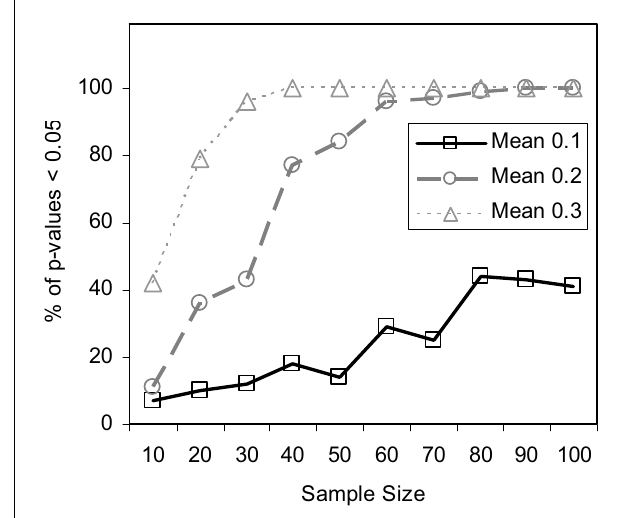
FIGURE 5 | Power of the MDMR procedure as a function of signal-to-noise ratio obtained from 1000 simulated data sets for a wide variety of settings. Simulated data for 30 ( N = 30) samples and 100 variables ( P = 100) were generated with 15 samples assigned to a control group (independent variable = 0) and 15 samples assigned to an experimental group (independent variable = 1). Random data in the control group were generated as standard normal variates with a mean of 0 and variance 1. Random data in the experimental group were generated as standard normal variates with variance = 1 and means that took on values of 0–1.5 in increments of 0.001.The power of the permutation-based statistical test is presented.We generated different simulated data sets for which 100, 50, 25, 10, or 5% of the variables used in the construction of the distance matrix had means adjusted from 0 (in the appropriate increments) in the experimental group.The gray line shows the power of a Bonferroni corrected P -value for the Student’s t -tests performed on each of the 100 variables in univariate t -tests which were corrected for the hundred statistical tests pursued.